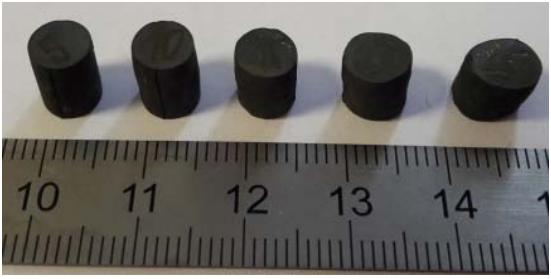
Figure 2. Specimens of nickel ‐ based alloys.